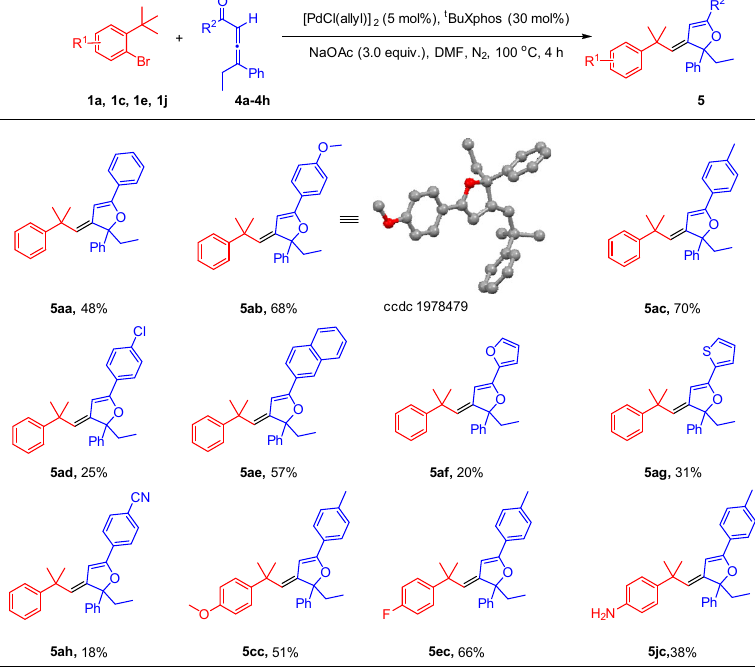
Fig. 3 Substrate scopes of aryl bromides and allenes. [a] Reaction conditions: 1 (0.1 mmol, 1.0 equiv), 4 (0.2 mmol, 2.0 equiv), [Pd(Cl(allyl)] 2 (5 mol%), t BuXphos (30 mol%), NaOAc (3.0 equiv), DMF (1 mL), under N 2 , 100 °C, 4 h. Yields of isolated products. key palladacycle intermediate IM4 . The barrier for the OA is calculated (Fig. 8b). Path A involves alkyne-activation cyclization small while the barrier for the CMD process is 25.0 kcal/mol. followed by migratory insertion (Cycle A in Fig. 7), while Path B From the key palladacycle intermediate IM4 , two possible engages protonation fi rst and then alkyne-activation cyclization paths (consideration of the two cycles shown in Fig. 7) were (Cycle B in Fig. 7). Clearly, Path A requires to pass through a very